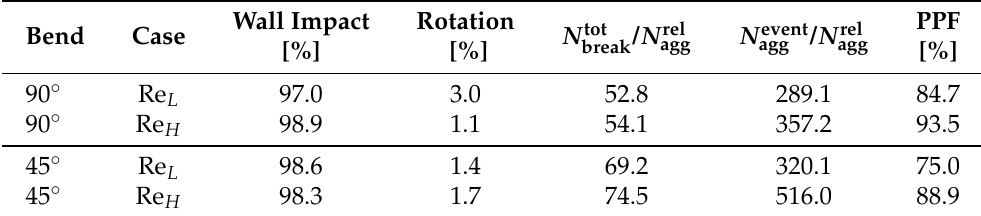
Table 3. Summary of the main breakage results obtained in the pipe bends. The evaluation time interval is ∆ T ∗ = 350 starting at the release of the first